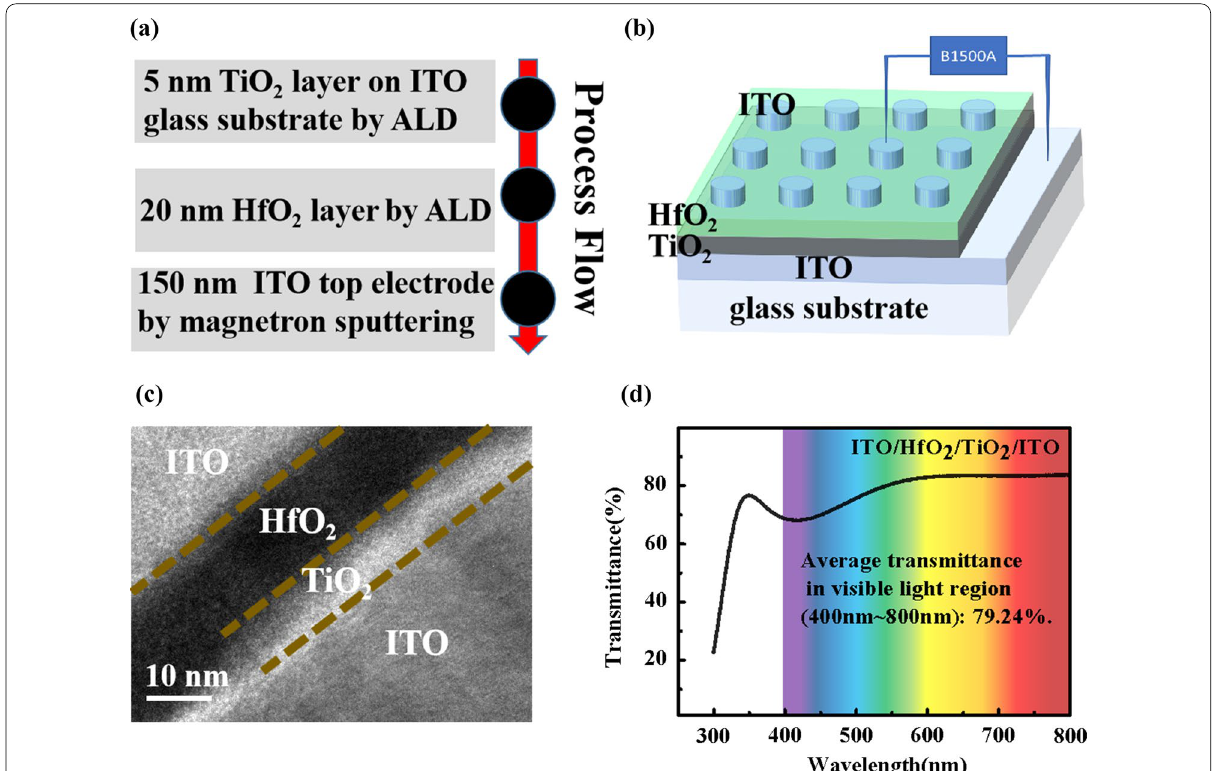
Fig. 1 a Device fabrication process. b Schematic description of the ITO/HfO 2 /TiO 2 /ITO memristors. c Typical cross‑sectional TEM image of the device. d UV–visible spectrum of the